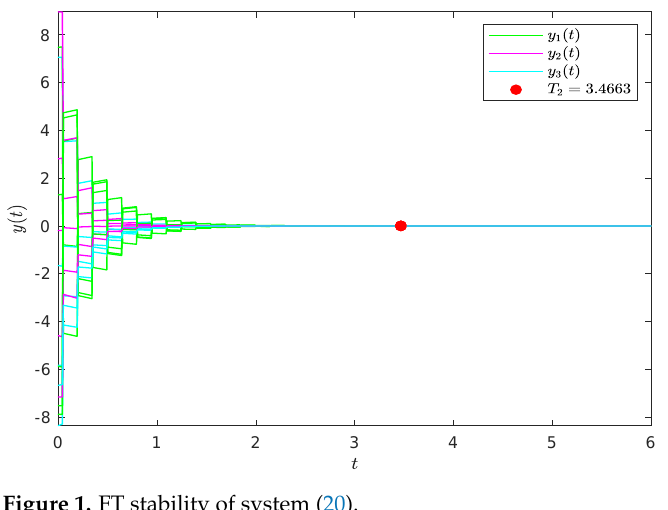
Figure 1. FT stability of system